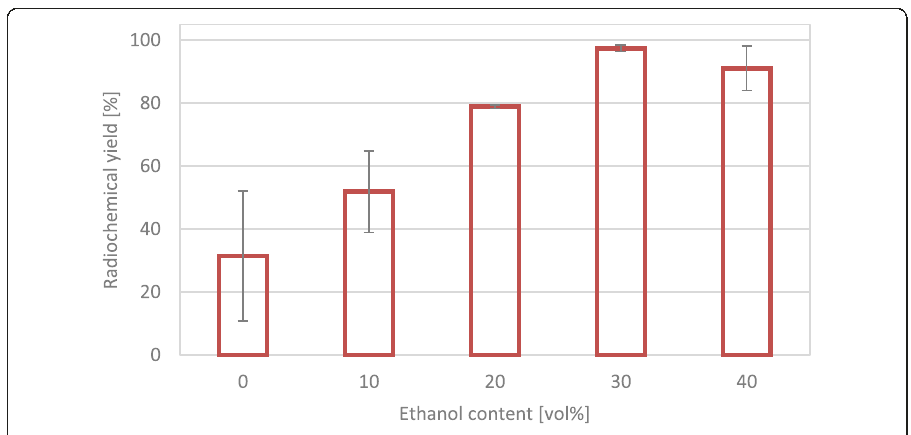
Fig. 3 Radiochemical yield depending on ethanol content (vol%) in the reaction mixture. 10 μ g (7.03 nmol) DOTA-TOC, T = 95 °C, t = 420 s, 500 μ l eluent solution, 0.52 ml 0.5 M ammonium acetate buffer (pH 4.5) for 0 – 40 vol% ethanol, overall pH 3.6 – 3.8. All experiments were performed minimum 4